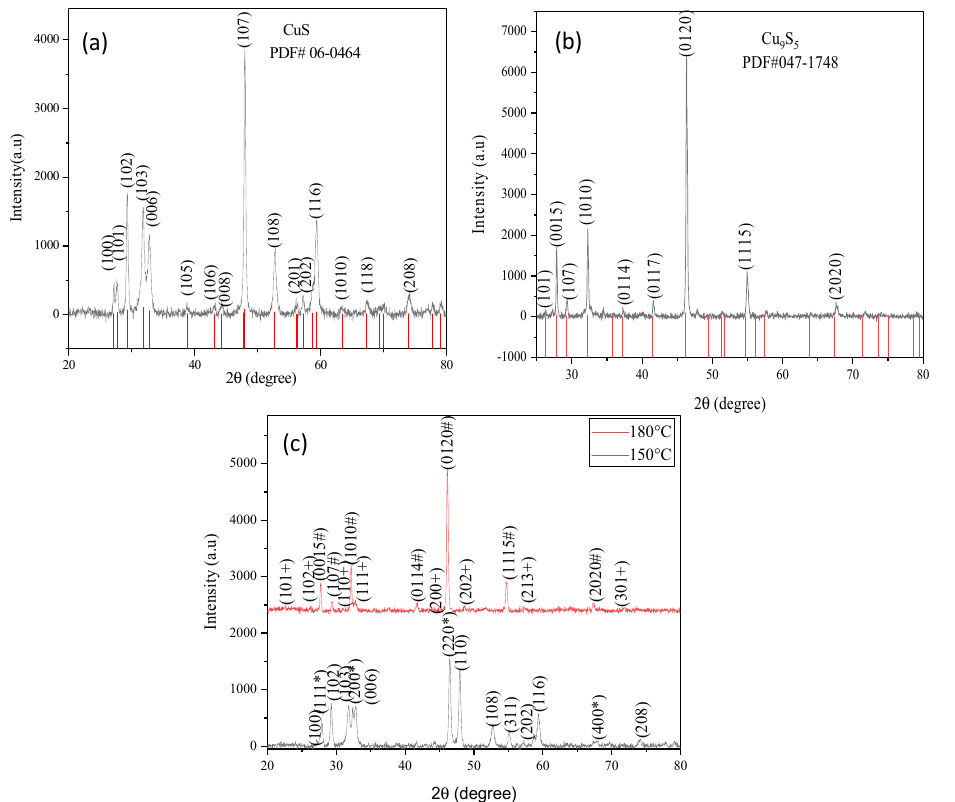
Figure 1. XRD patterns of ( a ) pure covellite, ( b ) pure digenite, and ( c ) mixed phases of copper sulfide (# Cu 9 S 5 , * Cu 7.2 S 4 , and + Cu 2 S) nanoparticles obtained from the thermolysis of the copper(II) dithiocarbamate complex.